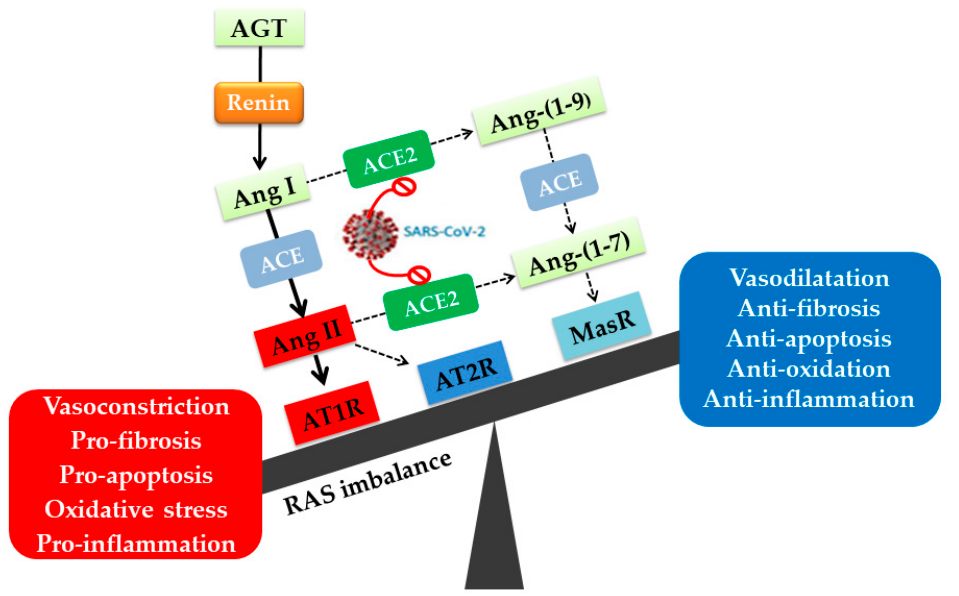
Figure 1. The dysregulation of the renin-angiotensin system (RAS) caused by SARS-CoV-2 infection . Upon SAR-CoV-2 entry, the downregulation of ACE2 decreases its ability to degrade Ang I and Ang II into Ang-(1-9) and Ang-(1-7), respectively. This is marked by excessive activation of the classical ACE-Ang II AT1R axis of RAS characterized by vasoconstriction, inflammation, apoptosis, fibrosis, and oxidative stress. AGT: angiotensinogen; Ang I: angiotensin; Ang II: angiotensin II; AT1R: angiotensin II type I receptor; AT2R: angiotensin II type II receptor; ACE2: angiotensin-converting enzyme 2; MasR: Mas receptor.